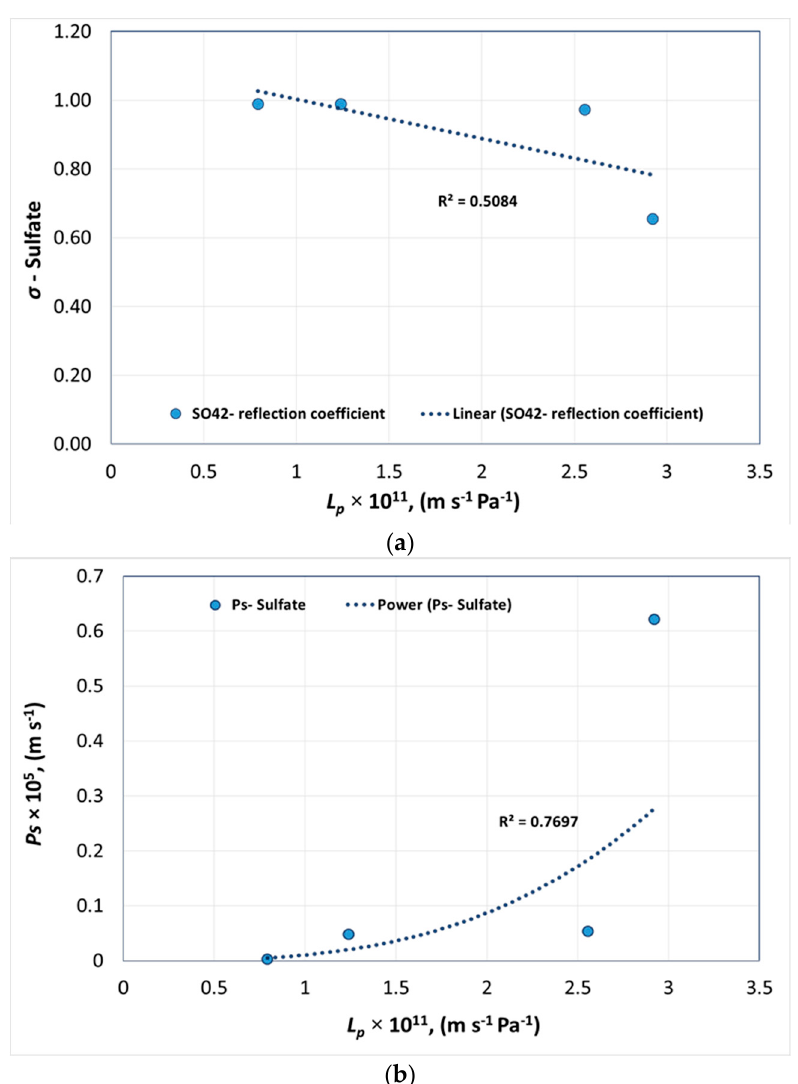
Figure 5. Pure water permeability versus ( a ) reflection coefficient and ( b ) solute permeability of sulfate.